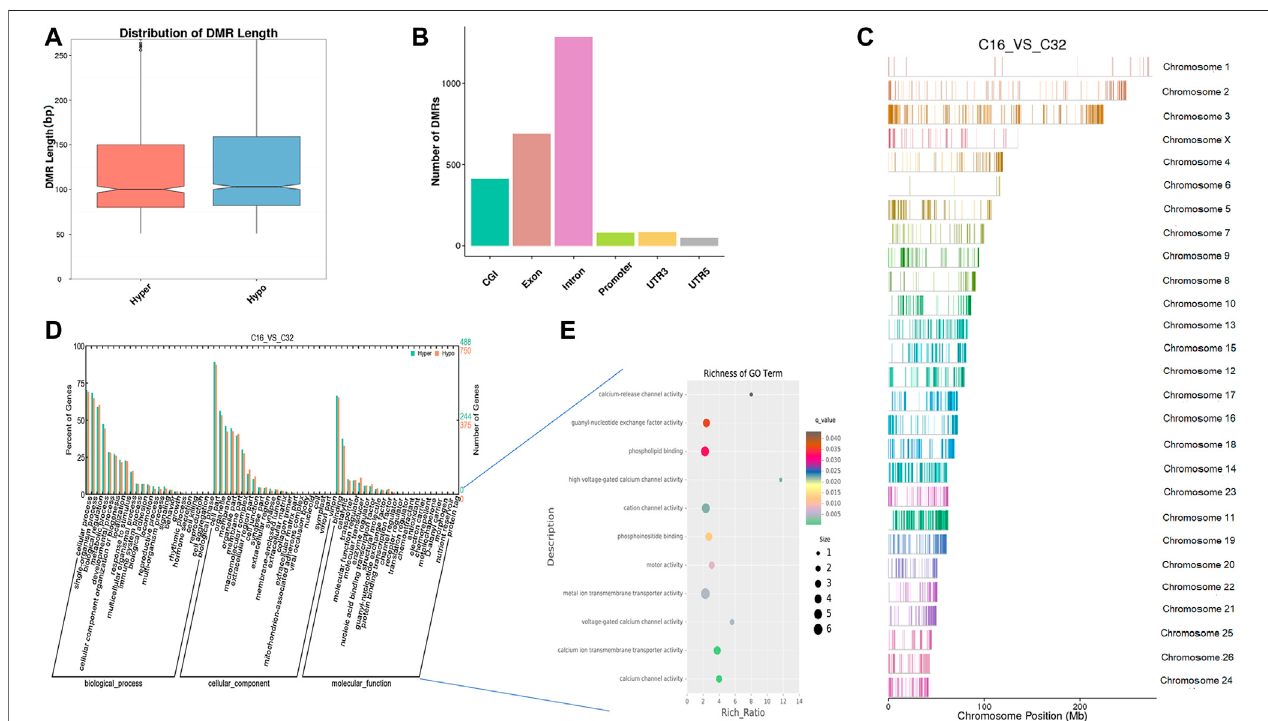
FIGURE5| Differentiallymethylatedanalysisfromthe16-cellstagetothemorulastage. (A – C) DMRlength,functionalannotation,anddistributioninchromosomes at these stages. The length of DMRs: the horizontal axis represents the methylation status of the DMRs, Hyper is relatively hypermethylated, Hypo is relatively hypomethylated, and the vertical axis represents the length of the DMRs (A) . The functional annotation of DMRs: the horizontal axis represents different genomic functional regions, promoters, exons, etc.; the vertical axis represents the number of DMRs annotated to a particular functional region (B) . The location of DMRs in thesheepgenome:thehorizontal axisrepresentsthechromosomal location,theverticalaxis represents thechromosome (C) . (D,E) GOenrichment analysis. Basedon the structuralannotation results ofthe DMRs in thegenome, functional enrichmentanalysiswas performed for geneswhere the DMR overlapped with thepromoterand gene body. The abscissa is each major class under GO terms, the left ordinate is the proportion ofthe class, and the right ordinate is the speci fi cnumber ofgenes in the class. Differentcolorsrepresent differentgroups (D) .The signi fi cantlyenriched GOterm wasscreened forscatter plotdisplay. The sizeofeach dot indicates thenumber of differential methylated genes contained in the term, and the color of the dots corresponds to a different q -value. Rich Ratio refers to the ratio between the number of differentially methylated genes enriched in the GO term and the background number. The larger the Rich Ratio, the greater the degree of enrichment. The q -value is the adjusted p -value after multiple hypothesis testing. The q -value is (0,1). The smaller the q -value, the more signi fi cant the enrichment (E) .